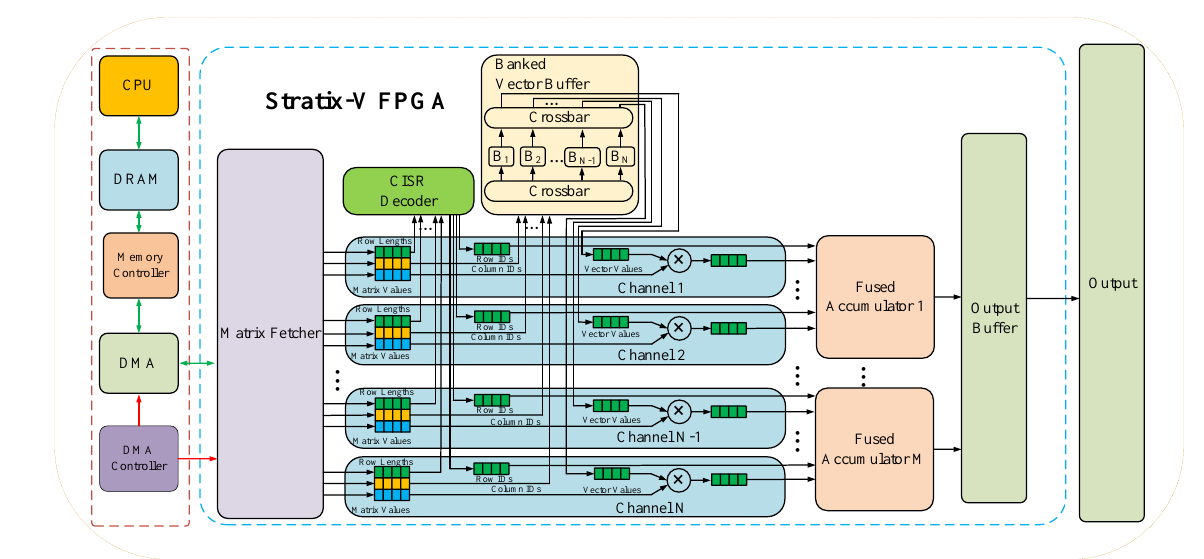
Figure 7. Neural network optimization technology based on FPGA.